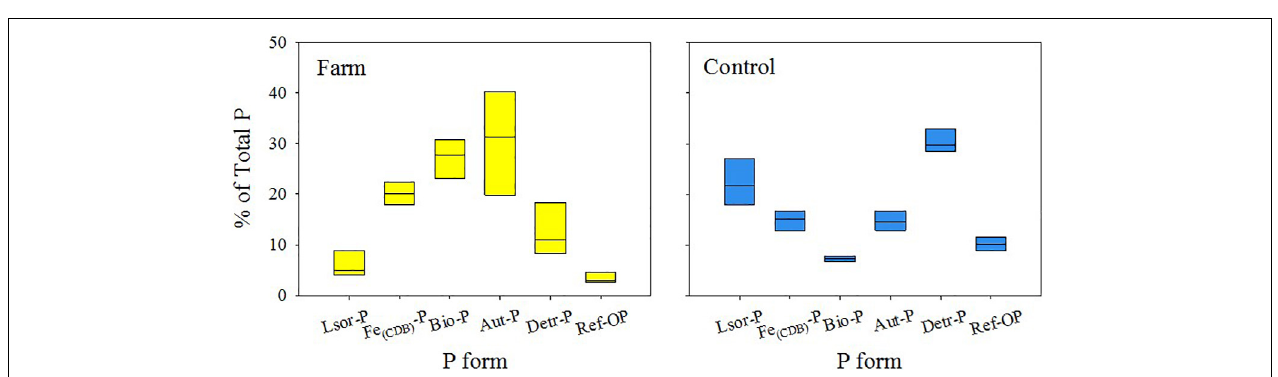
FIGURE 5 | Vertical profiles of P forms in the fish farm and control sediment.